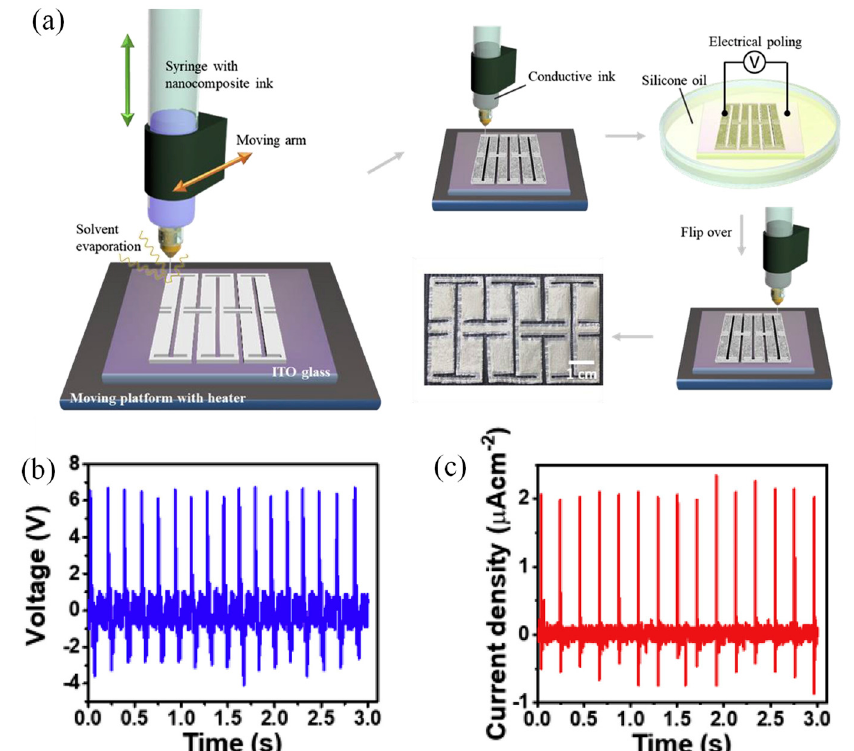
Figure 9. Fabrication of a 3D-printed kirigami PENG. ( a ) Schematic diagram of a 3D-printed PENG with kirigami structure. ( b ) Output voltage of the fabricated device. ( c ) Current density with 20 wt% of BaTiO3 NP/P(VDF-TrFE) at 60 N at 5 Hz on a 1 cm 2 area [118]. Adapted with permission from